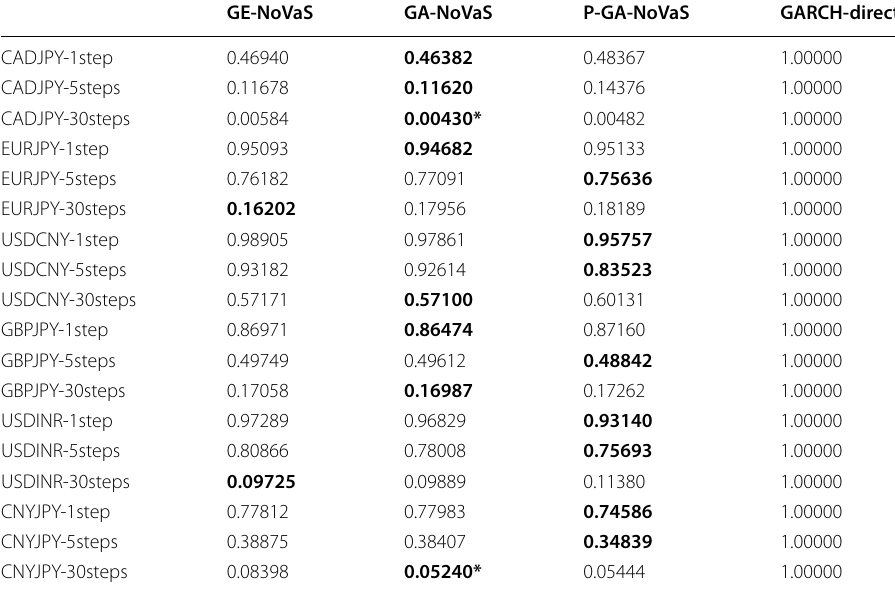
Table 6 Comparison results of using volatile 1-year currency